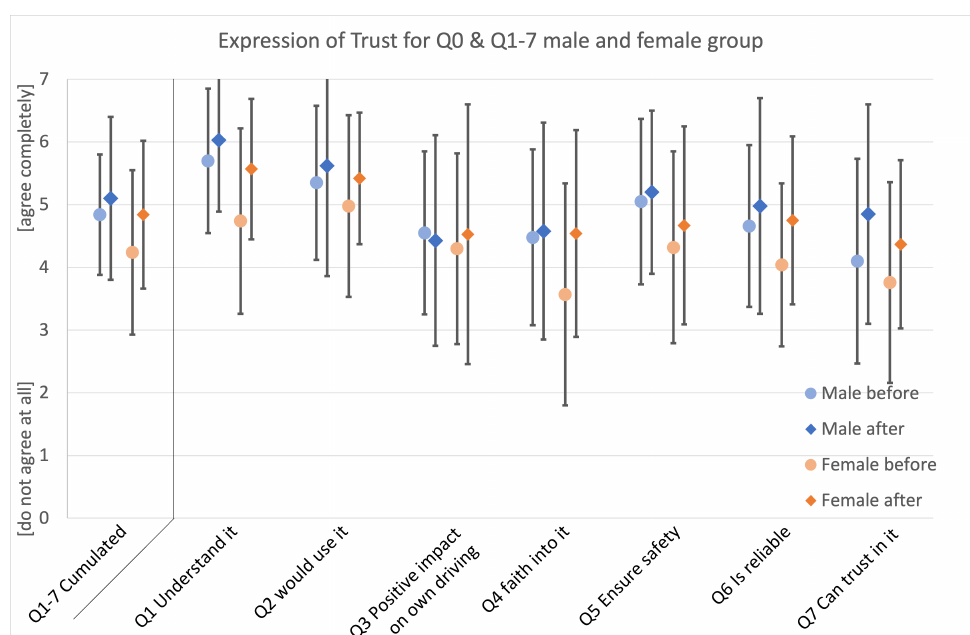
Figure 6. Expression of trust for question 0 (Q0—mean value) and detailed question 1–7 (Q1–7) for male and female groups, before and after the test. Table 2. Mean values (m), standard deviation (sd) and ANOVA-results for Gender x Time. Male Female